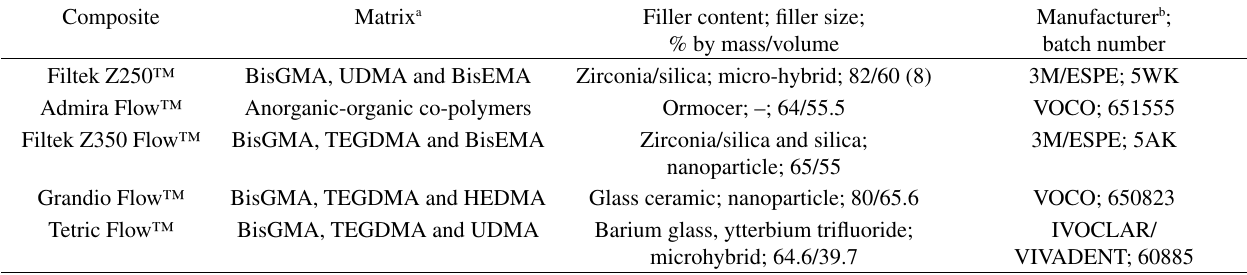
Table 1. Composition, manufacturer and batch number of the materials.